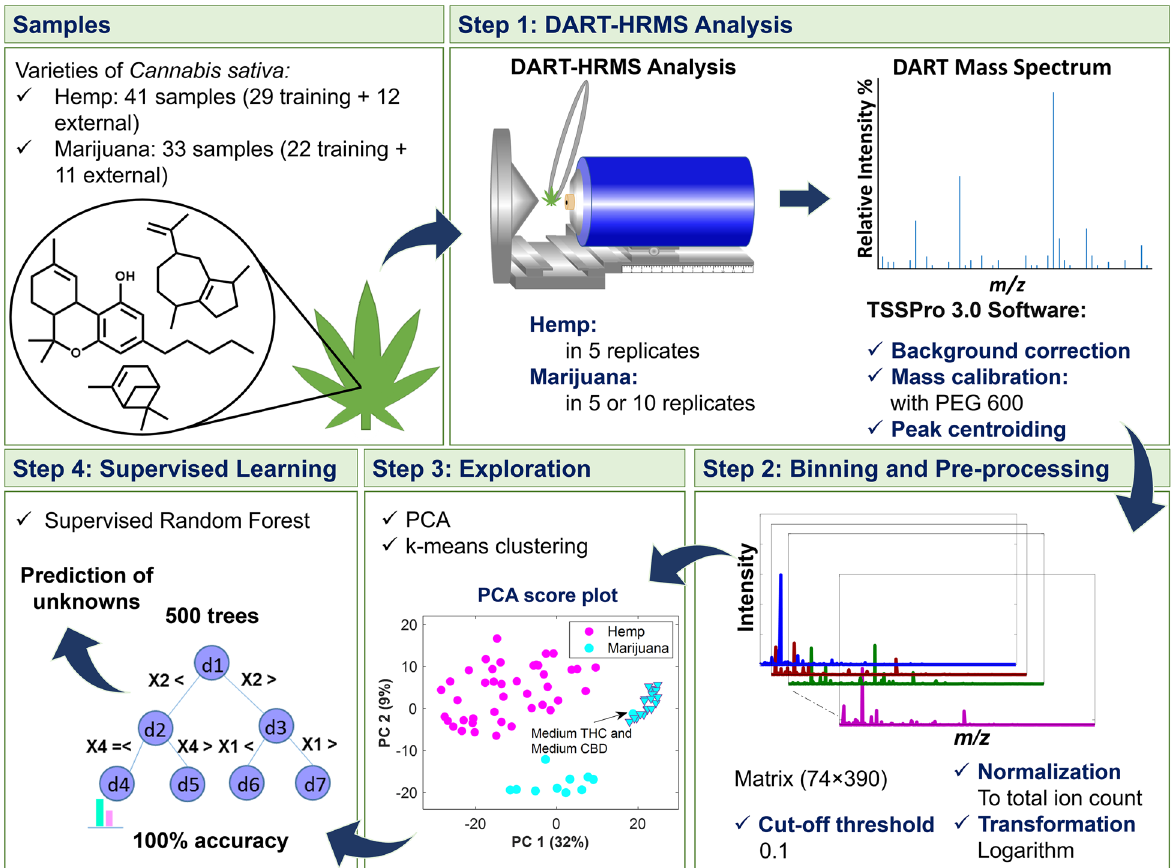
Fig. 1 Workflow for discrimination of hemp and marijuana